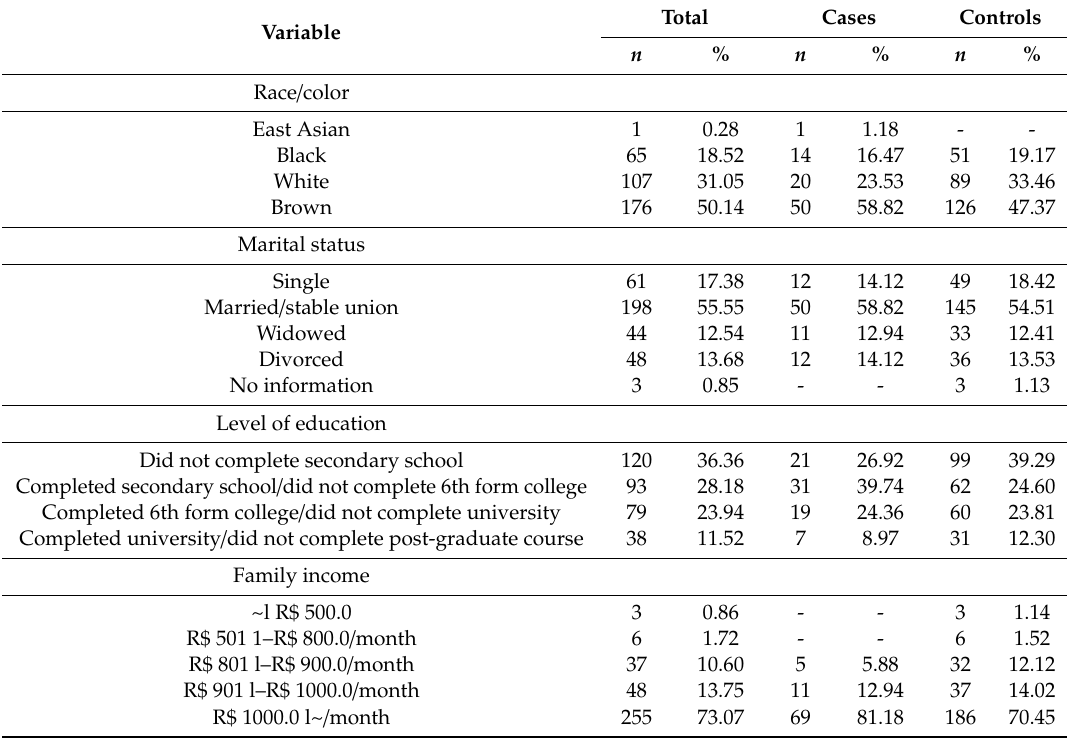
Table 1. Distribution of socio-demographic characteristics of cases and controls associated with breast cancer, Rondon ó polis-MT, November 2017 to April 2018. Variable